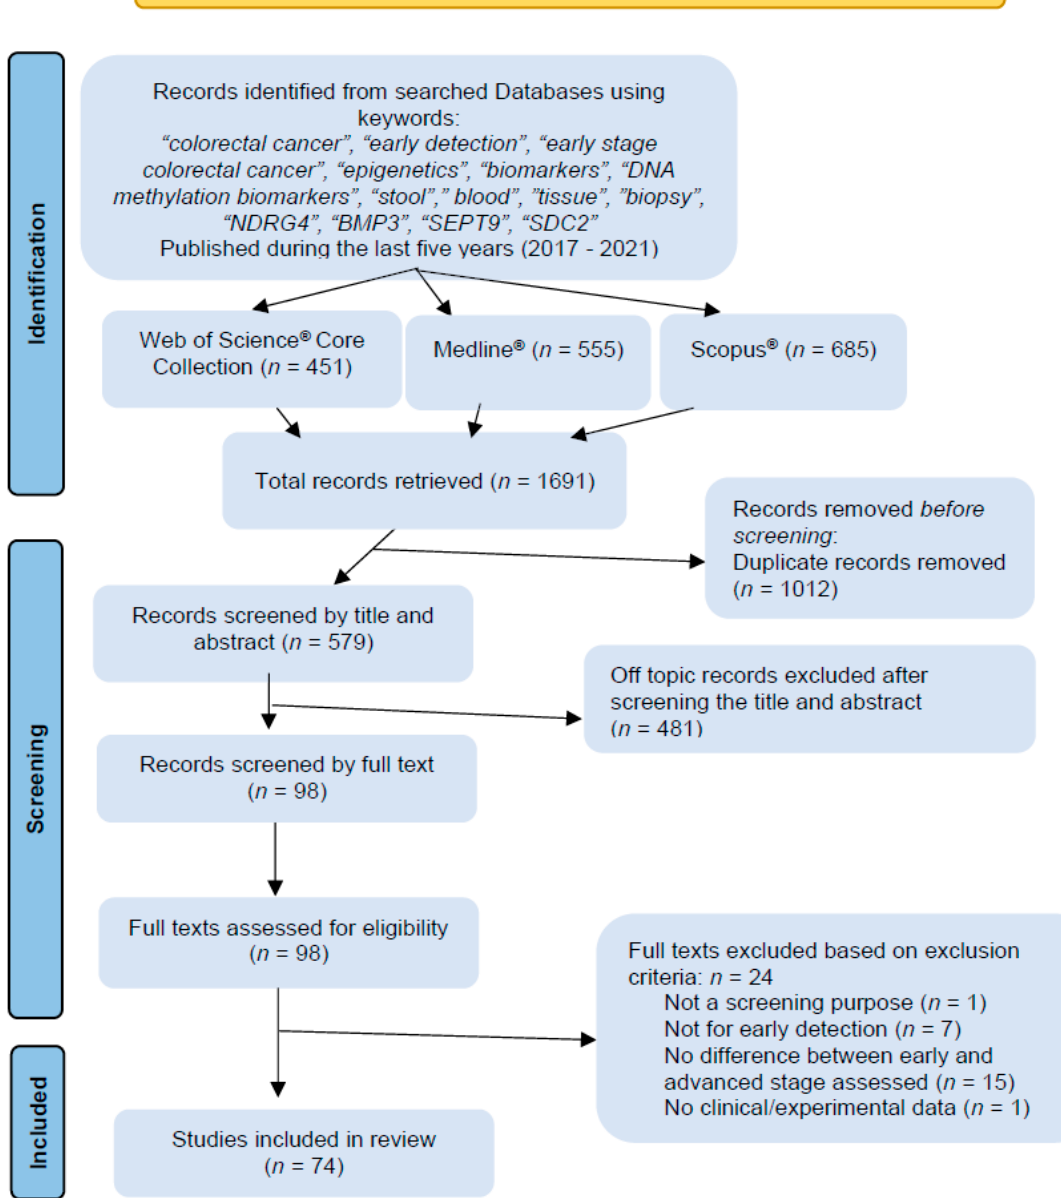
Figure 2. Preferred Reporting Items for Systematic Review and Meta-Analysis (PRISMA) diagram illustrating the literature search process.